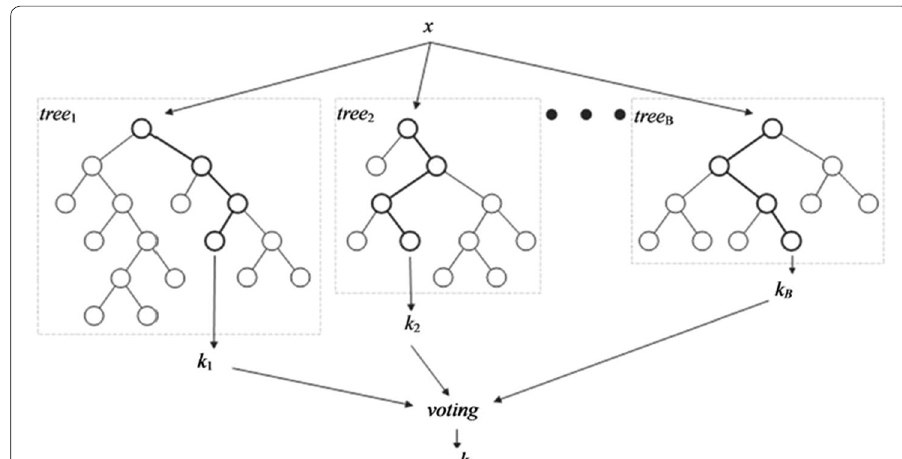
Fig. 4 Random forest with multiple decision trees